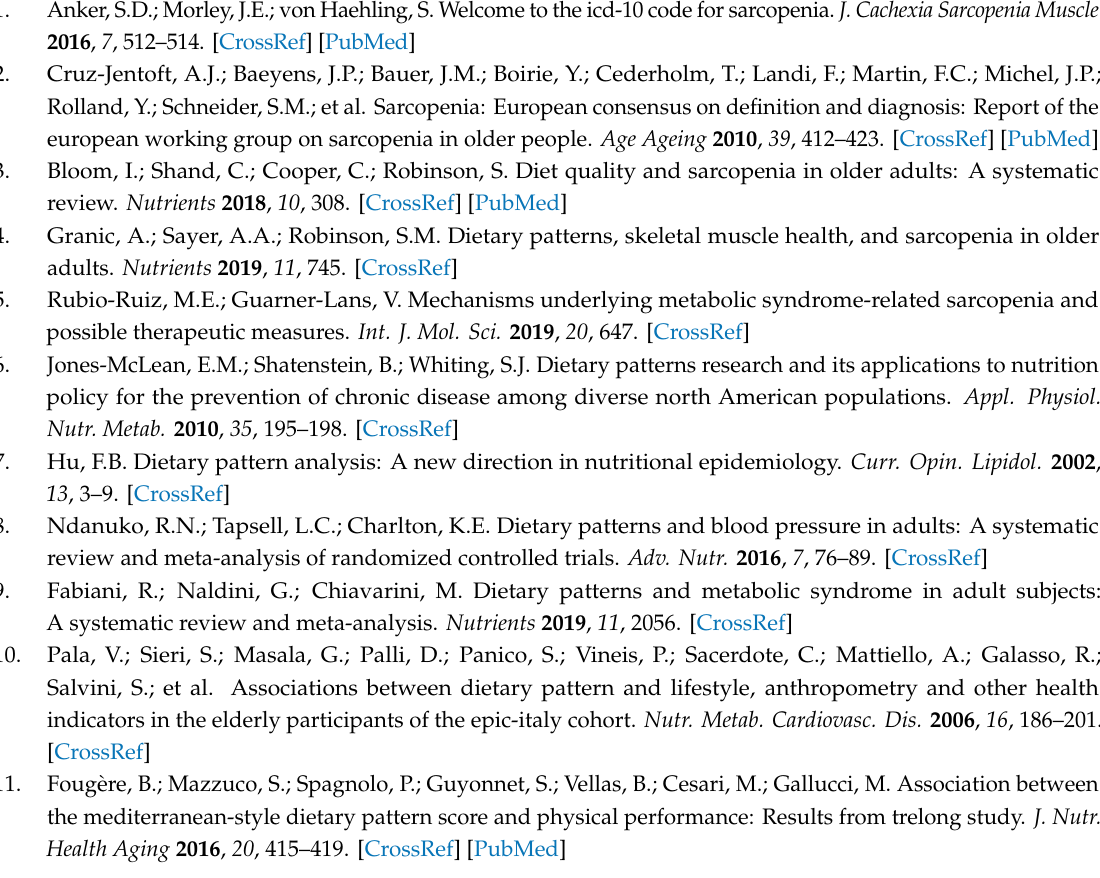
Table S1: Participants characteristics among di ff erent quartiles of DP1, Table S2: Participants characteristics among di ff erent quartiles of DP2, Table S3: Participants characteristics among di ff erent quartiles of DP3, Table S4: Associations between dietary variety, DPs and sarcopenia defined by AWGS2019, Table S5: Renal indicators among the highest quartiles of three